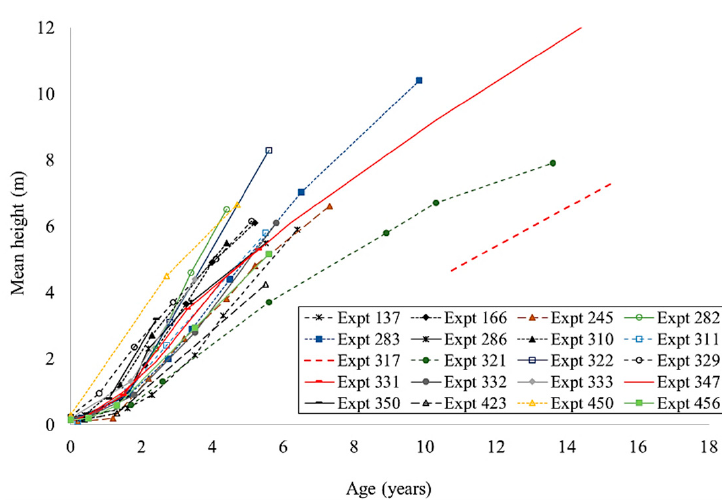
Figure 4. Theheightgrowthof Flindersiabrayleyana inenrichmentplantingexperimentsinnorthQueensland. Figure 4. The height growth of Flindersia brayleyana in enrichment planting experiments in north Queensland.